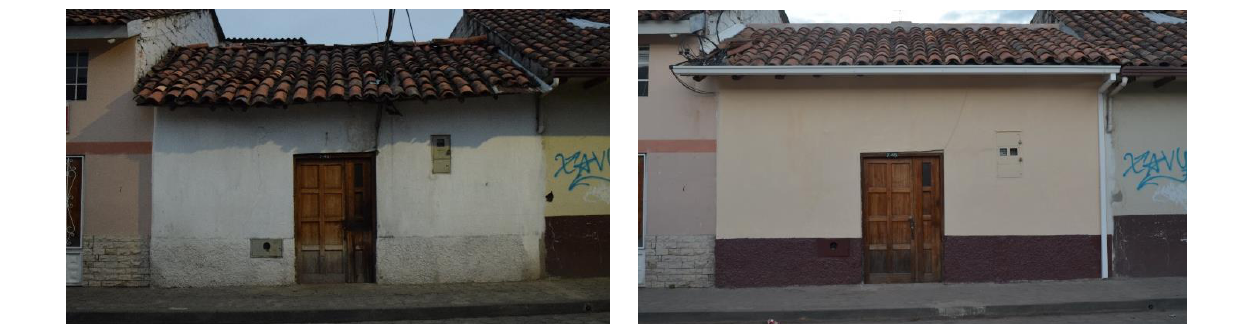
Figure 4. Before the Herrerías Maintenance Campaign Source: City Preservation Management project.